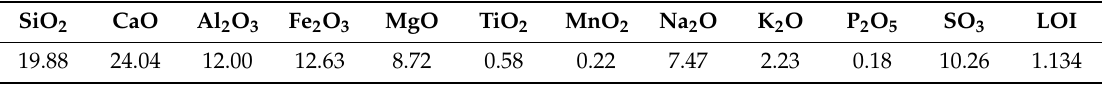
Table 2. The chemical composition of Nii Tanasa fly ash (in wt